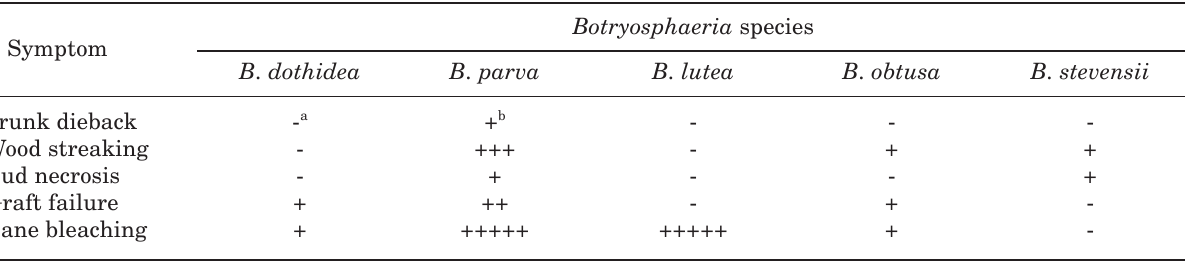
Table 4. Pathogenic effect of Botryosphaeria spp. on grapevine (from Phillips, 2002).